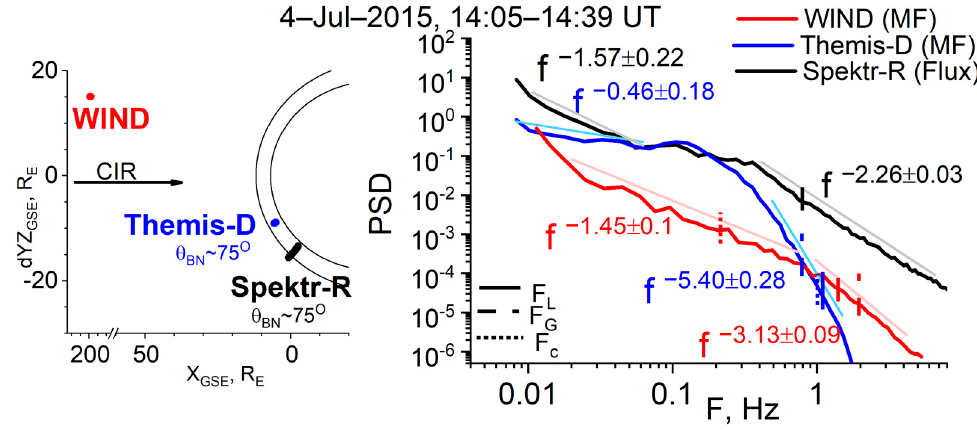
Figure 4. ( Left )—spacecraft positions; ( right )—comparison of the normalized Fourier spectra for the SW of type CIR.